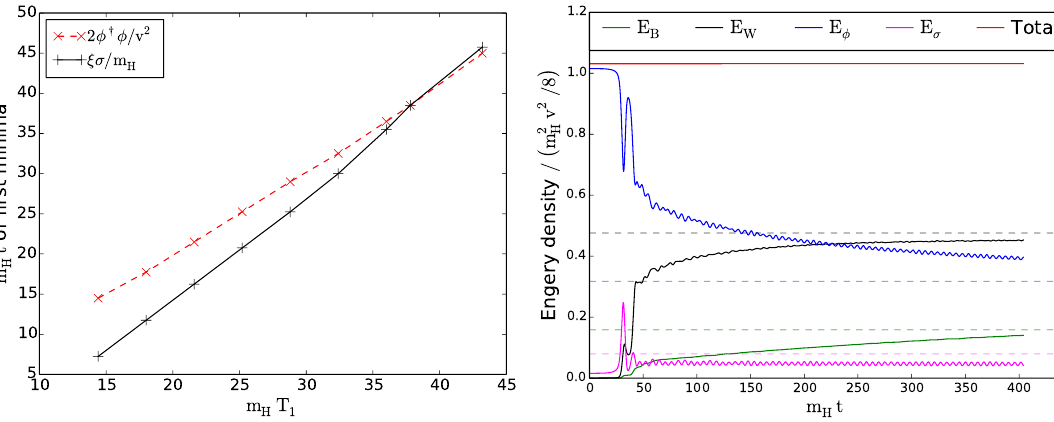
Figure 4 . Left: the time of the (cid:12)rst Higgs minimum and (cid:12)rst (cid:27) minimum for di(cid:11)erent quench times. Right: the energy components in an n = 8, m H =m = 28 simulation ( B is U(1) gauge (cid:12)eld, W is SU(2). (cid:30) and (cid:27) the two scalar (cid:12)elds. Dashed lines denote the expected equipartition